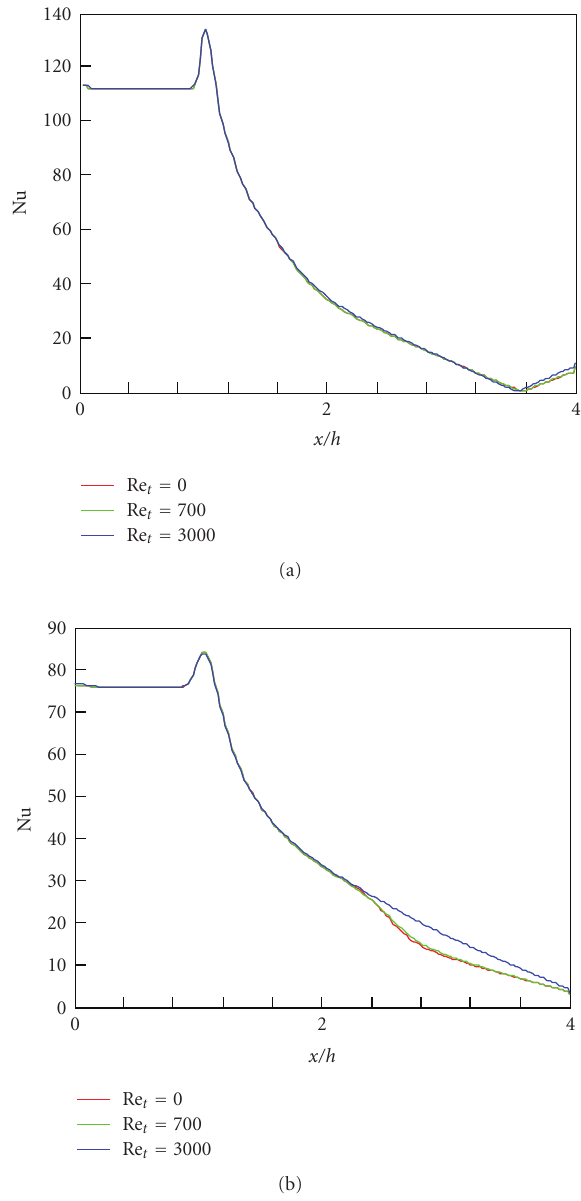
Figure 5: Local Nusselt Number on the Rotating Disk Surface for Re = 2000, (a) h/D i = 0 . 05 and (b) h/D i = 0 . 10. in rotating disk, for h/D i = 0 . 05, are the same as that in the stationary disk, while the corresponding fields for h/D i = 0 . 10 are a ff ected by the disk rotation, and the recirculation zone appears in the outlet of the rotating disk, resulting in a substantial deformation of the velocity and thermal fields. The presence of the recirculation zone induces the temperature gradient near the heated wall at the outlet of the disk, resulting in an increase of heat transfer performance, as seen in Figure 5(b). Thus, the e ff ect of disk rotation on heat transfer performance is found to occur in the wider disk spacing. This trend became larger in the lower Reynolds number region (not